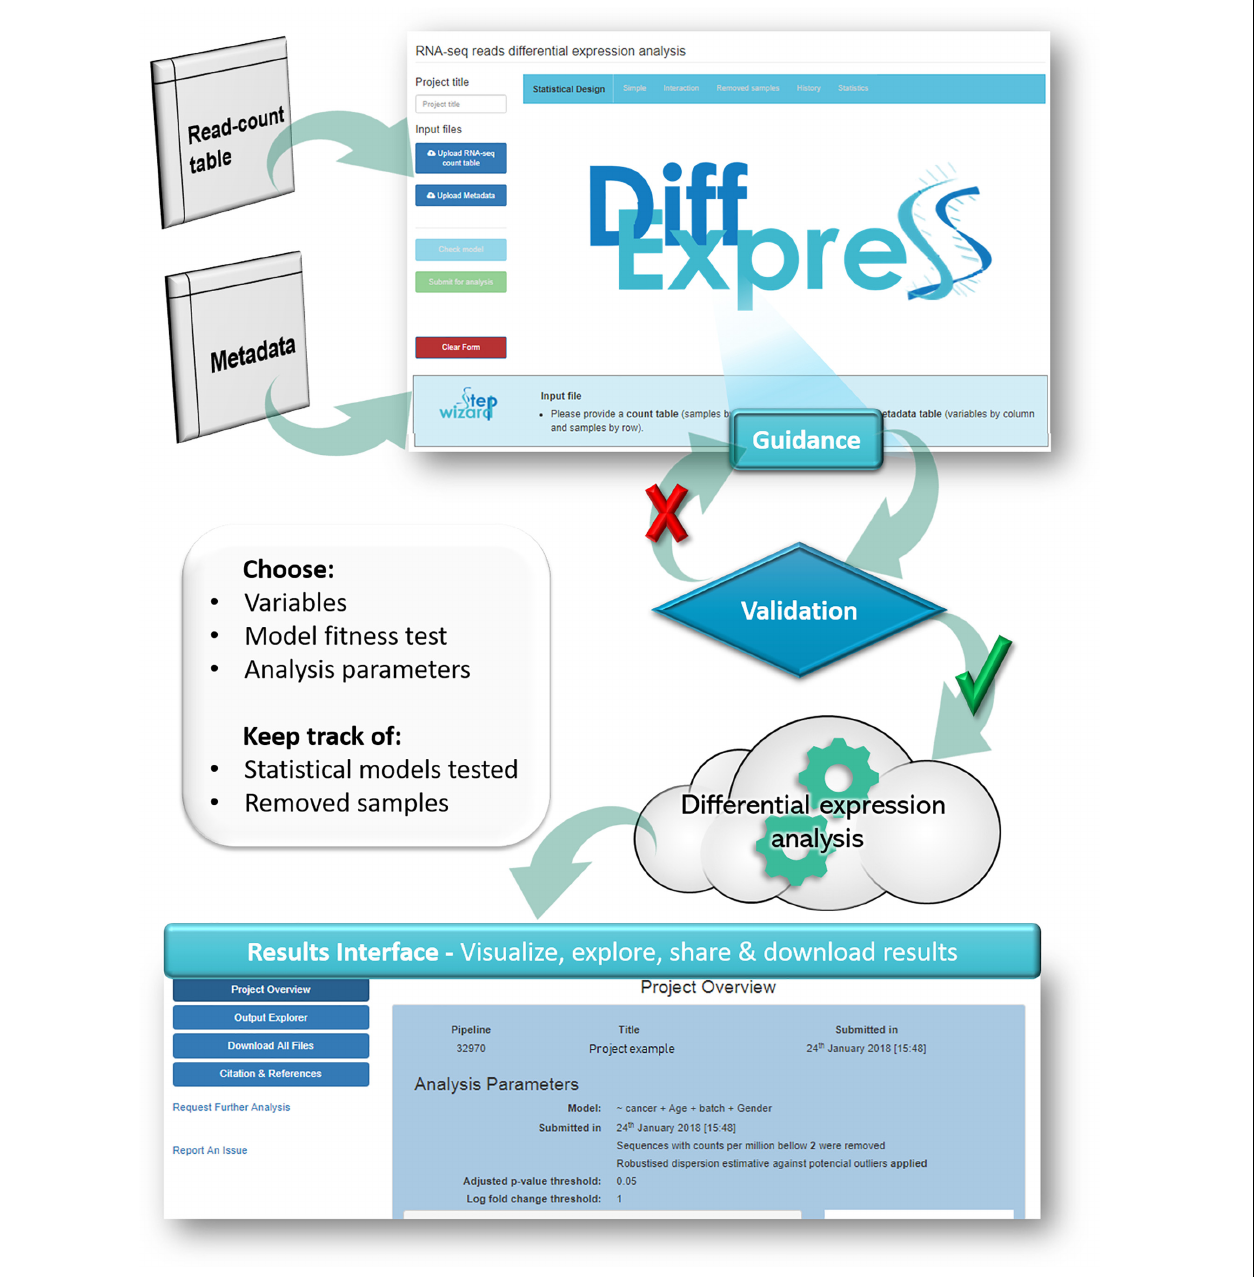
FIGURE 6 | Overview of the DiffExpress workflow. The web-interface requires a read-count table and a metadata as input. The users will set-up their analysis which will undergo a real-time validation prior to submission for analysis. If any issue is encountered, the interface will guide the users through the possible actions. Once the statistical model is successfully fitted, the pipeline can be submitted. The data will be sent to the cloud and once the analysis is finished, the users can retrieve and explore the results in a secondary web interface, linked to their